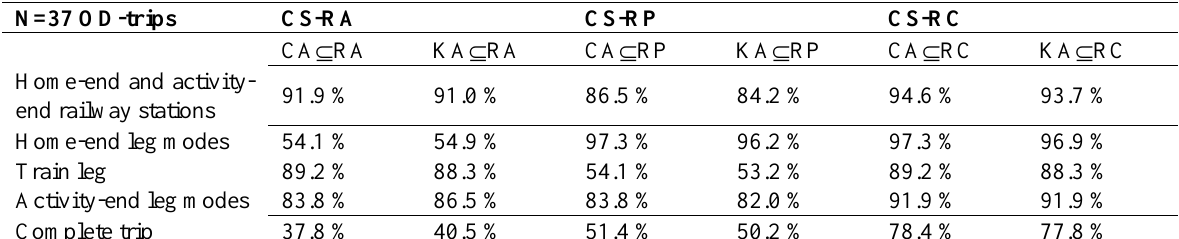
Table 3. Set Coverage Results for Each of the Three Generated Choice Sets: CS-RA, CS-RP,